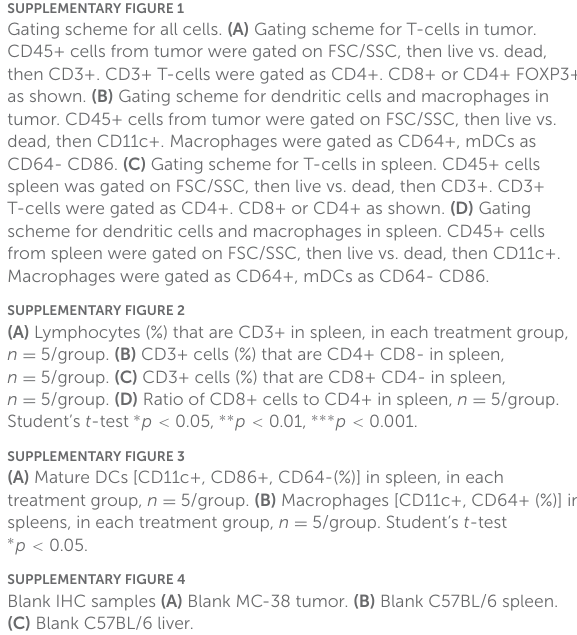
SUPPLEMENTARYFIGURE1 Gating scheme for all cells. (A) Gating scheme for T-cells in tumor. CD45+ cells from tumor were gated on FSC/SSC, then live vs. dead, then CD3+. CD3+ T-cells were gated as CD4+. CD8+ or CD4+ FOXP3+ as shown. (B) Gating scheme for dendritic cells and macrophages in tumor. CD45+ cells from tumor were gated on FSC/SSC, then live vs. dead, then CD11c+. Macrophages were gated as CD64+, mDCs as